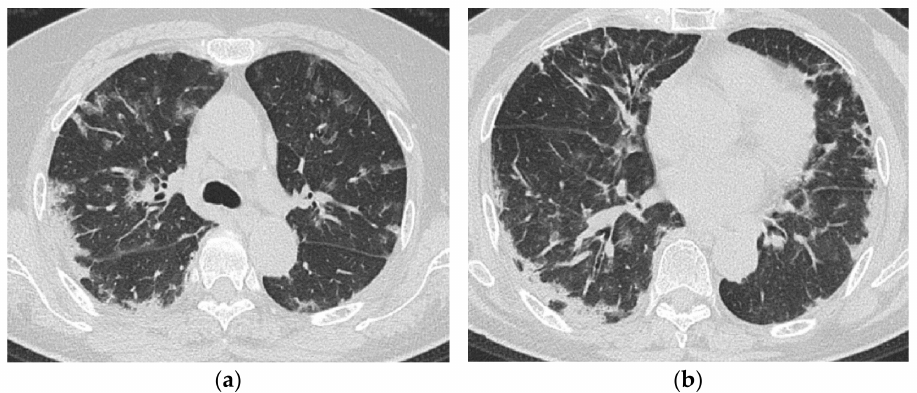
Figure 12. A 69-year-old woman with rapidly progressive interstitial lung disease associated with dermatomyositis (antibody unknown). On HRCT ( a , b ), bilateral diffuse patchy ground-glass opacifi- cation and consolidation are seen in both lungs. The distribution of the lesions is unbiased both in the vertical and horizontal directions. A transbronchial lung biopsy specimen showed diffuse edematous thickening of the alveolar septa and fibrin deposition, which was considered to correspond to acute lung injury (not shown). The patient died three weeks after